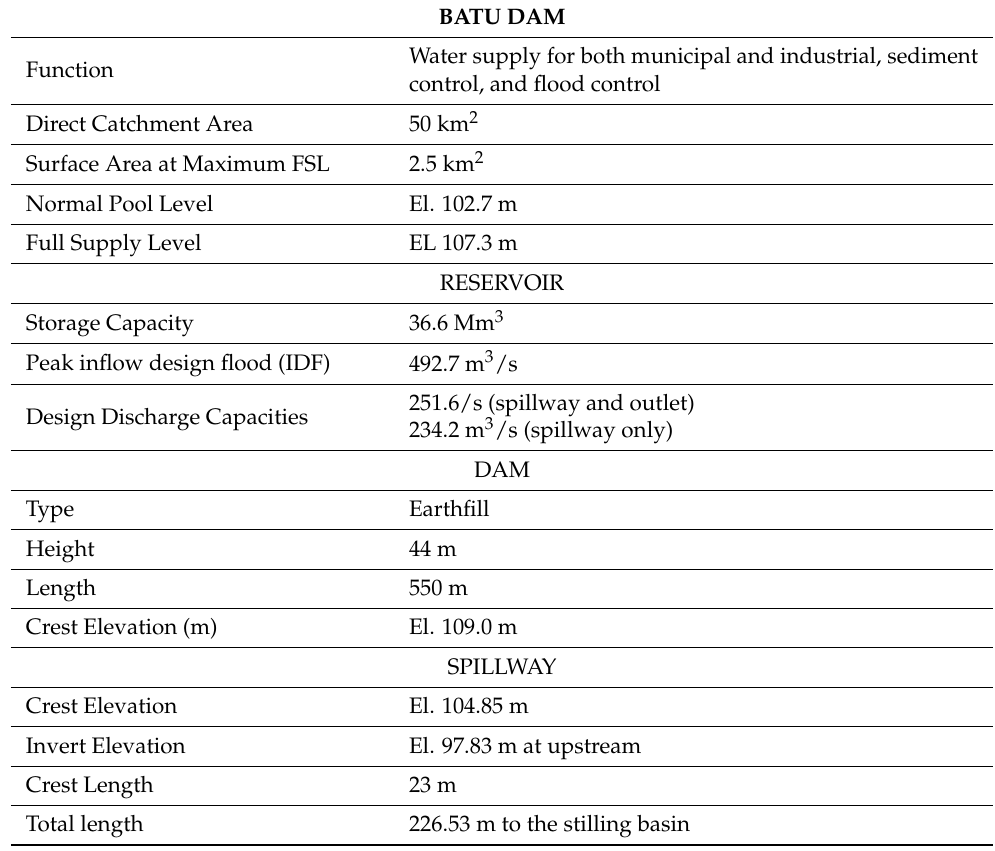
Table 1. Salient features of Batu